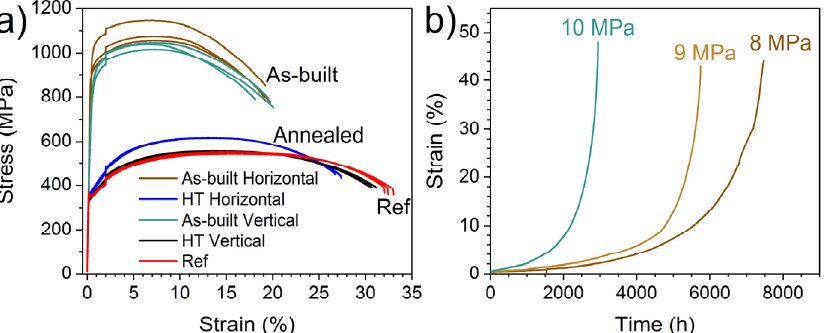
Figure 9. Mechanical properties of the SS446 ferritic stainless-steel showing ( a ) tensile stress–strain curves for the as-built annealed and reference samples and ( b ) creep curves for the L-PBF annealed sample.